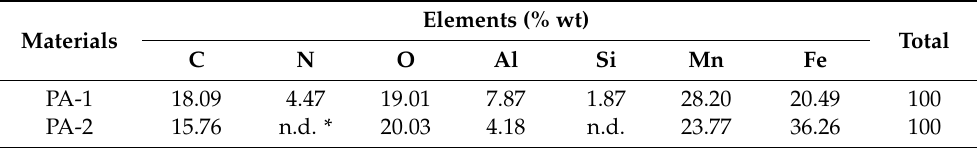
Table 2. Elemental analysis of PA materials by EDS mapping.